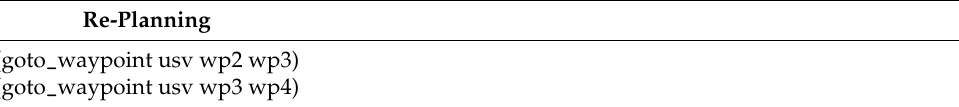
Table A2. Generated plans when